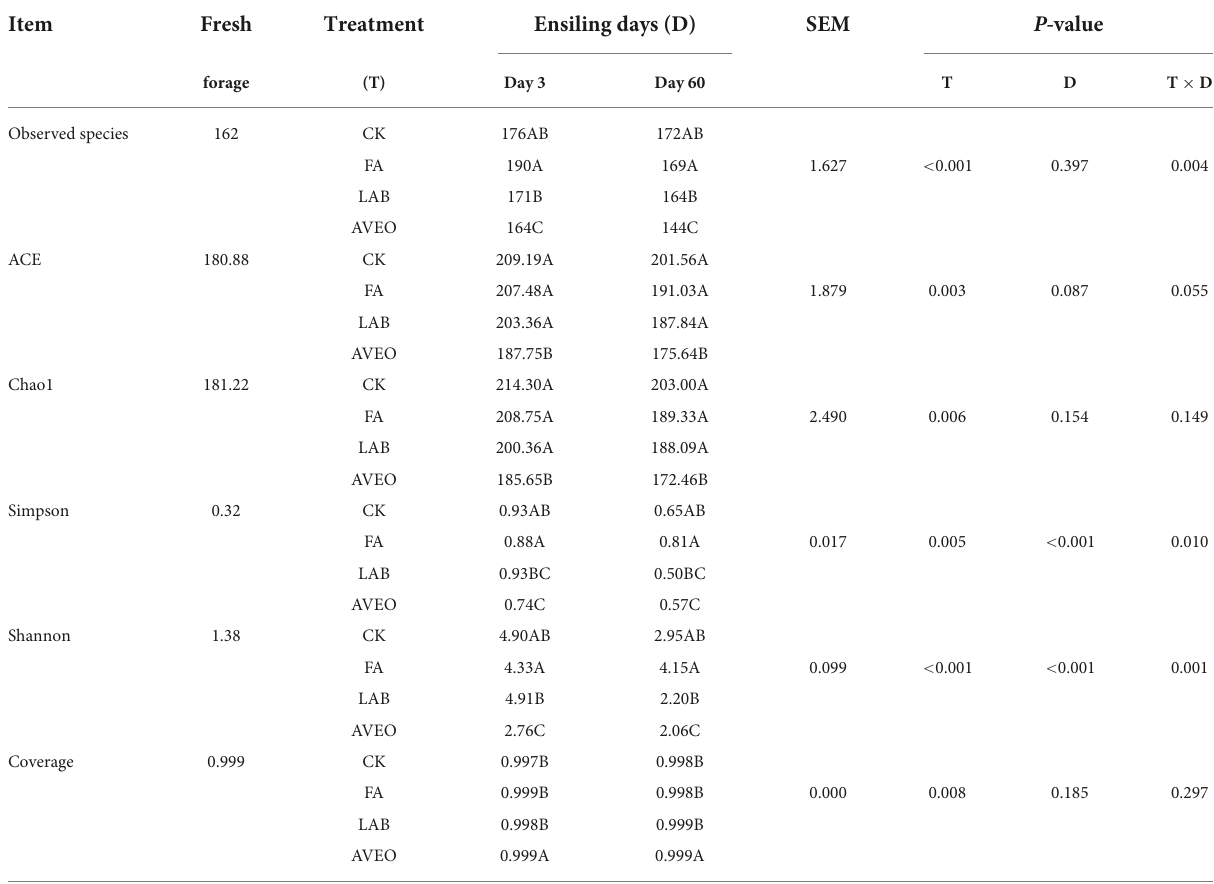
TABLE 3 Alpha diversity of bacteria of fresh and ensiled paper